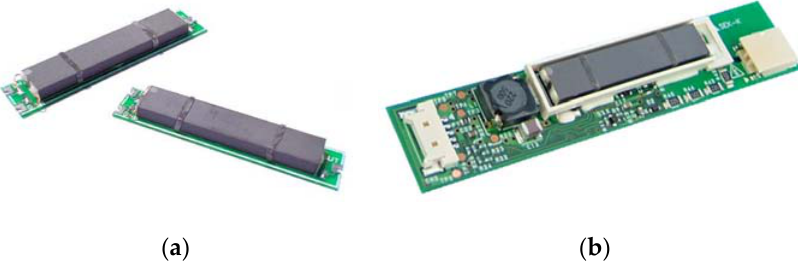
Figure 9. Piezoelectric inverter used in Apple Powerbook 15” and 17” computer for LCD backligting (courtesy of Micromechatronics, Inc., State College, PA, USA). ( a ) 5W piezoelectric transformer; ( b ) Assembled piezoelectric inverter.